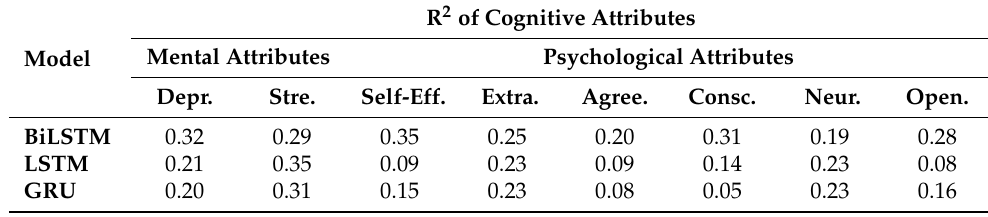
Table 3. Strength of the regression models from MPNet to psychological attributes and mental health status. R 2 of Cognitive Attributes Mental Attributes Psychological Attributes Model Depr. Stre. Self-Eff. Extra. Agree. Consc. Neur. Open. BiLSTM 0.32 0.29